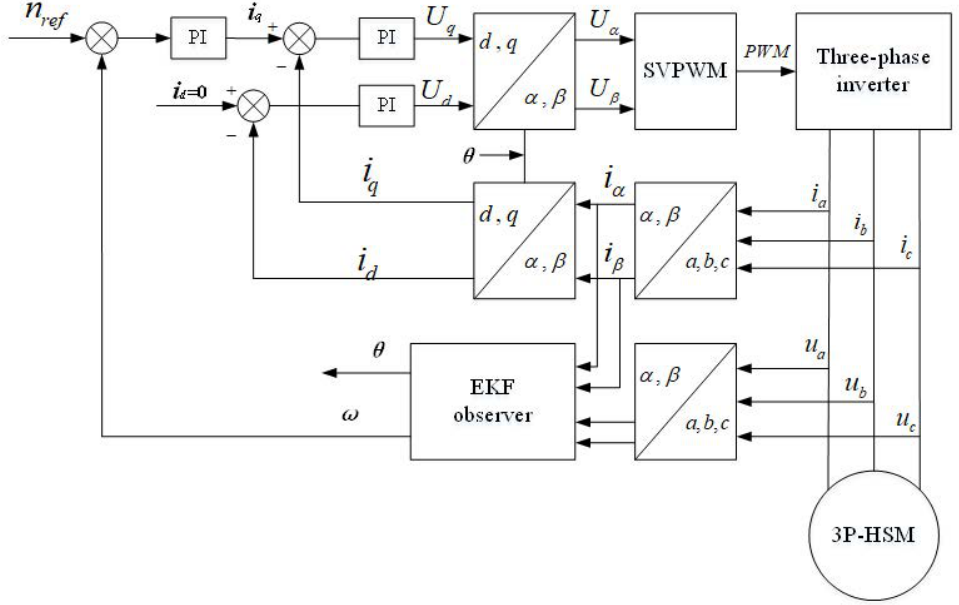
Figure 4. The overall control diagram of SCLC mode for the constant speed control.